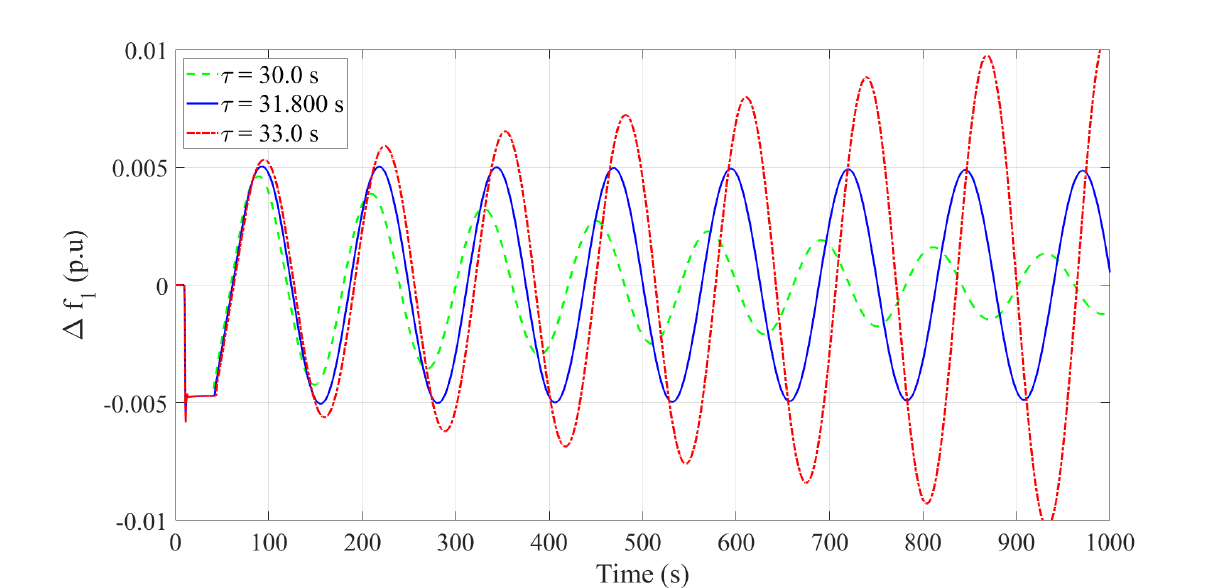
Figure 16. Frequency deviation for LFC − 1: ∆ f 1 was measured while using K P = 0.05 and K I =